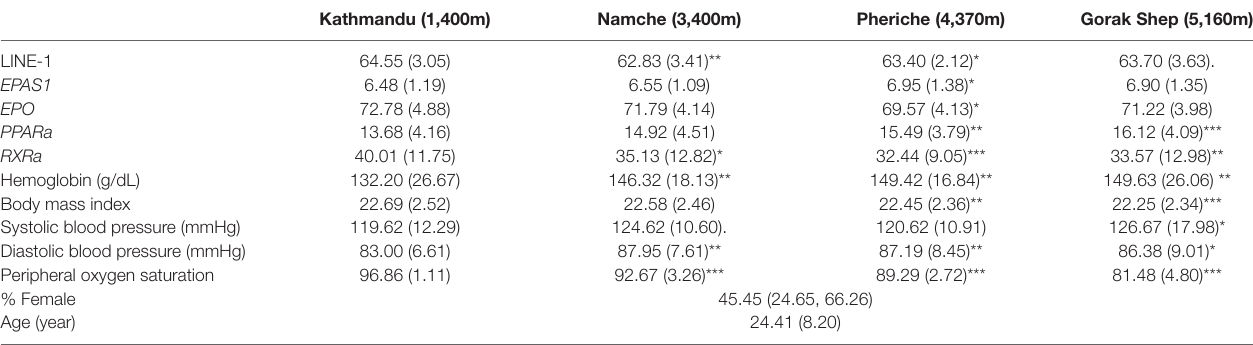
TABLe 1 | Participant characteristics and DNA methylation.